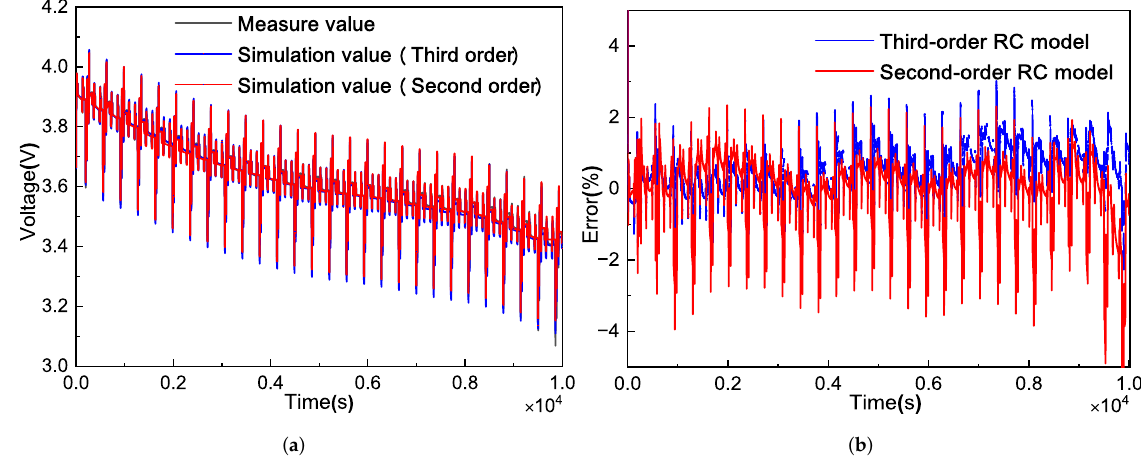
Figure 6. Terminal voltage comparison and its error curve under DST operating conditions: ( a ) Voltage, ( b ) Error.